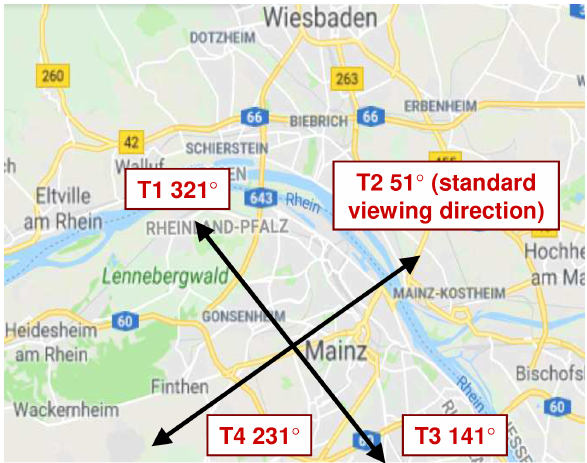
Figure A2. Azimuth viewing directions of the four telescopes (T1 to T4) of the MPIC MAX-DOAS instrument. The azimuth angles are defined with respect to north (© Google